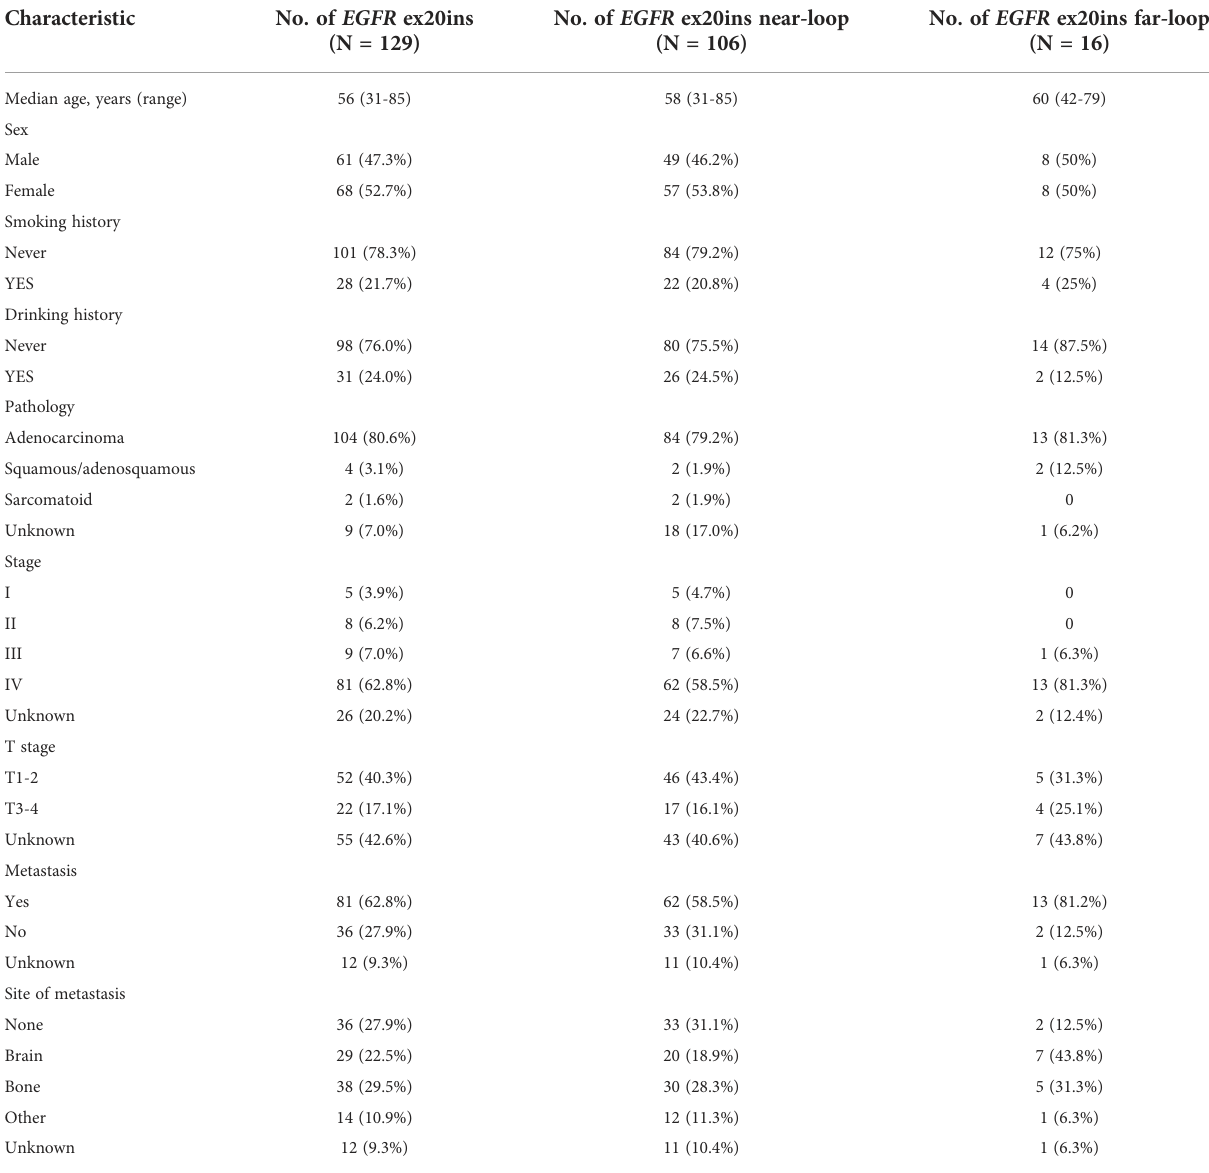
TABLE 1 Patient